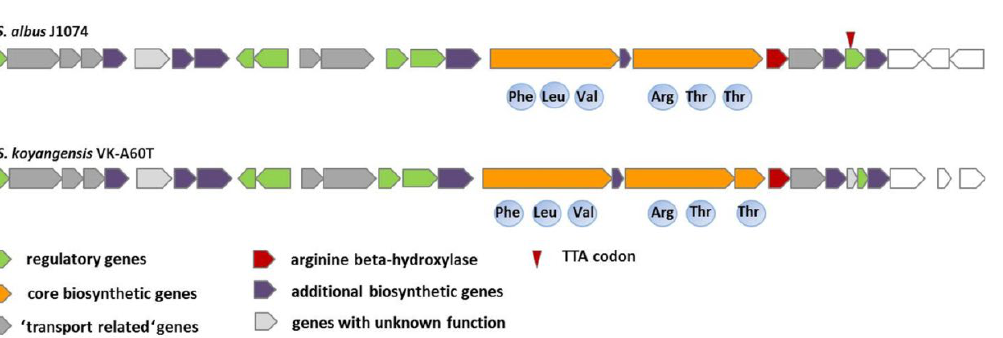
Figure 1. Structure of the flk clusters in the S. albus and S. koyangensis